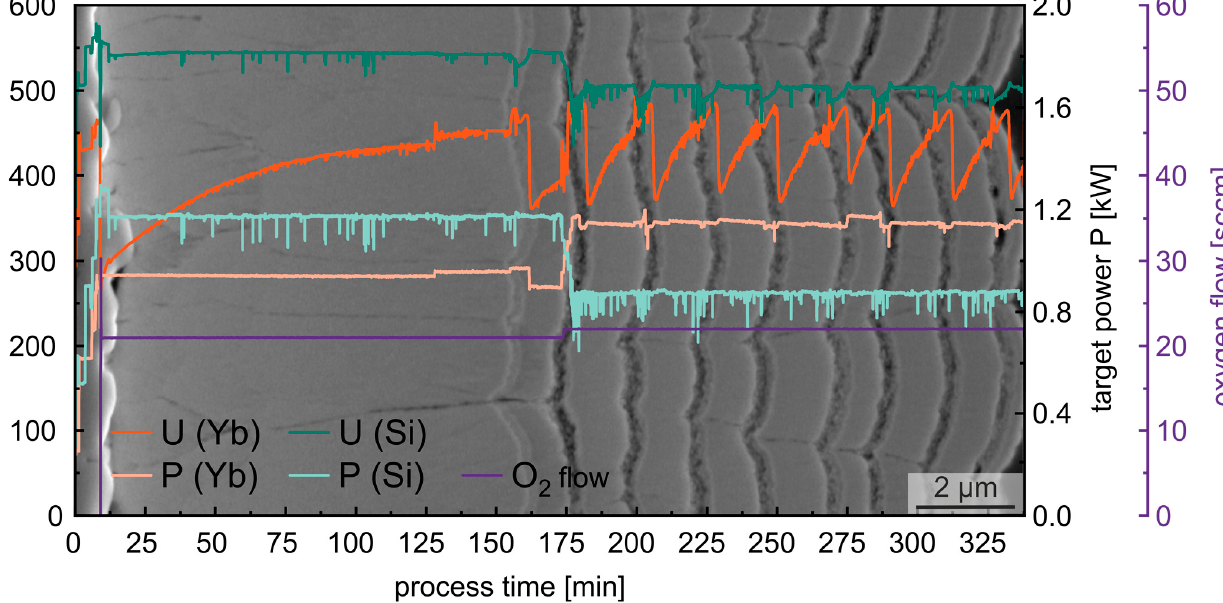
Figure 3. Process data of YbDS and YbMS coating by reactive magnetron sputtering and underlying the micrograph of the as-coated microstructure on an Al 2 O 3 substrate.